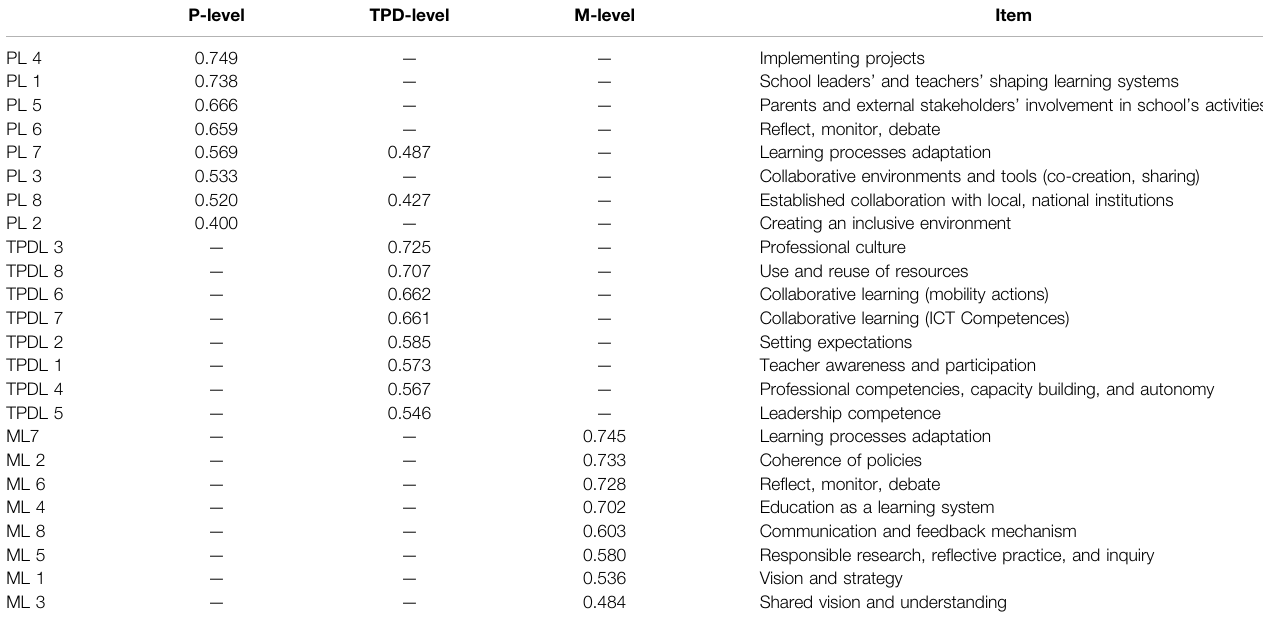
TABLE 3 | Loading pattern of the OSOS-SRT with its three-actor solution and the corresponding